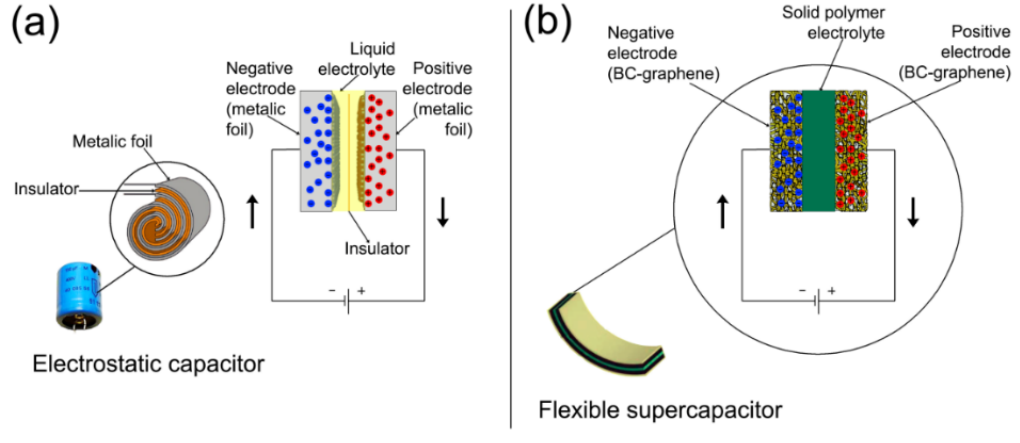
Figure 2. Schematic representation of an electronic capacitor ( a ) and a flexible electrochemical double-layer capacitor (EDLC) ( b ).